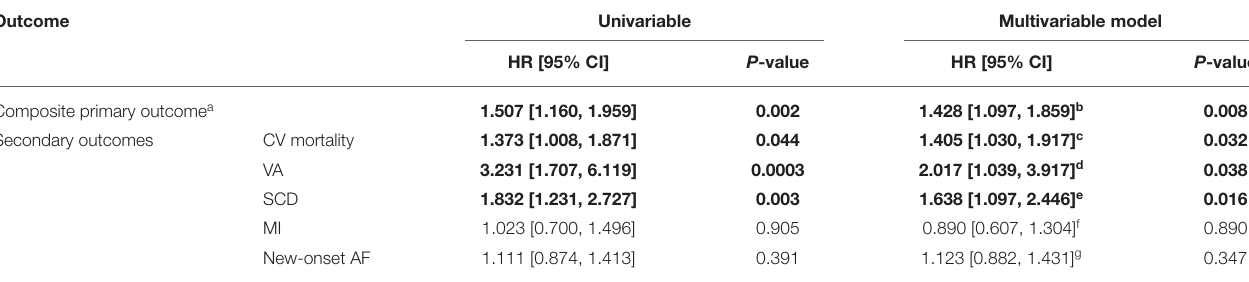
TABLE 2 | Cox regression analysis of all 2,182